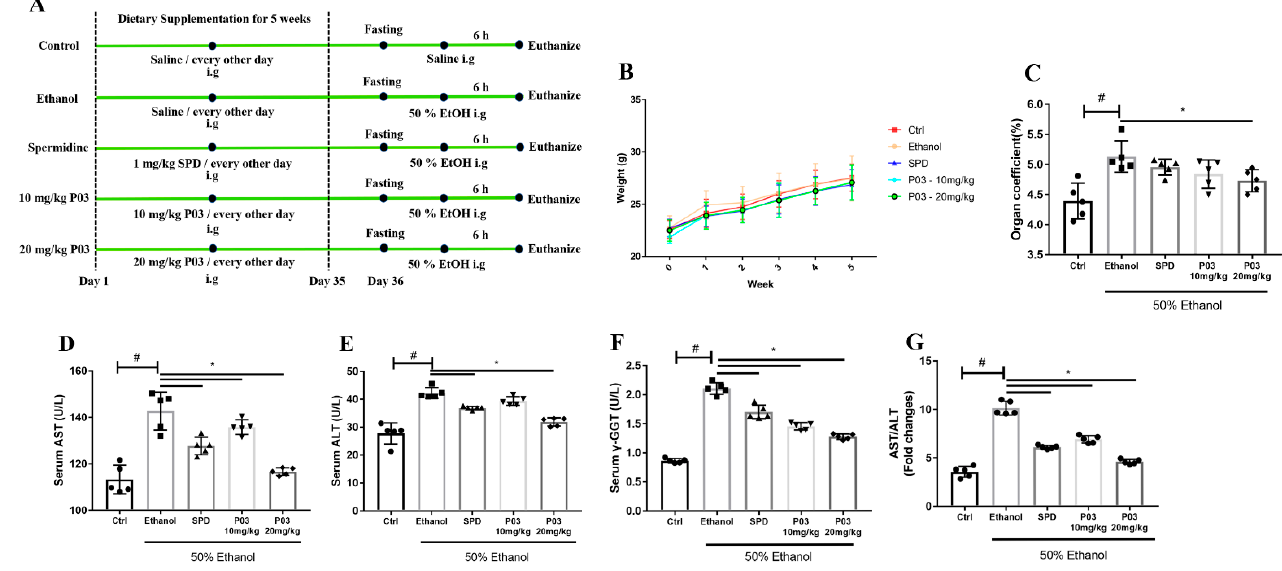
Figure 3. Peptide P03 attenuated hepatic injury induced by binge alcohol exposure. ( A ) Schematic diagram depicting the experimental approach to evaluate the effect of P03 supplementation on mice with binge alcohol exposure. ( B ) Body weight change. The data in week 0 represent the body weight of mice during acclimation. ( C ) Organ coefficients of acute ethanol-intoxicated mice in different groups. The organ coefficient = organ weight/body weight. ( D – G ) Serum alanine aminotransferase (ALT), aspartate aminotransferase (AST), gamma-glutamyl transpeptidase ( γ -GGT) levels and ratios of AST vs. ALT in different groups. Values are expressed as mean ± SD. (Compared to Ctrl, # p < 0.05. Compared to ethanol, * p < 0.05) ( n =